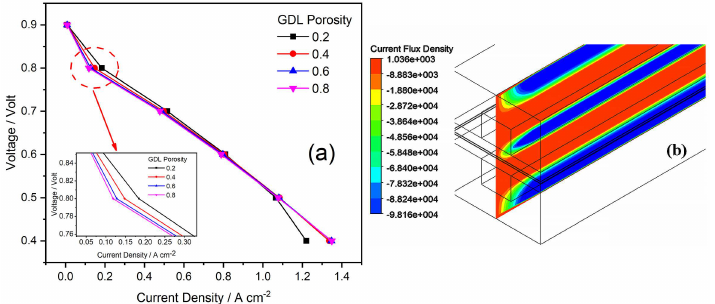
Figure 8. ( a , b ) Effects of GDL porosity on PEMFC performance: ( a ) Polarization curves of GDL porosity; and ( b ) Contours of the current flux density at 0.6 V for GDL